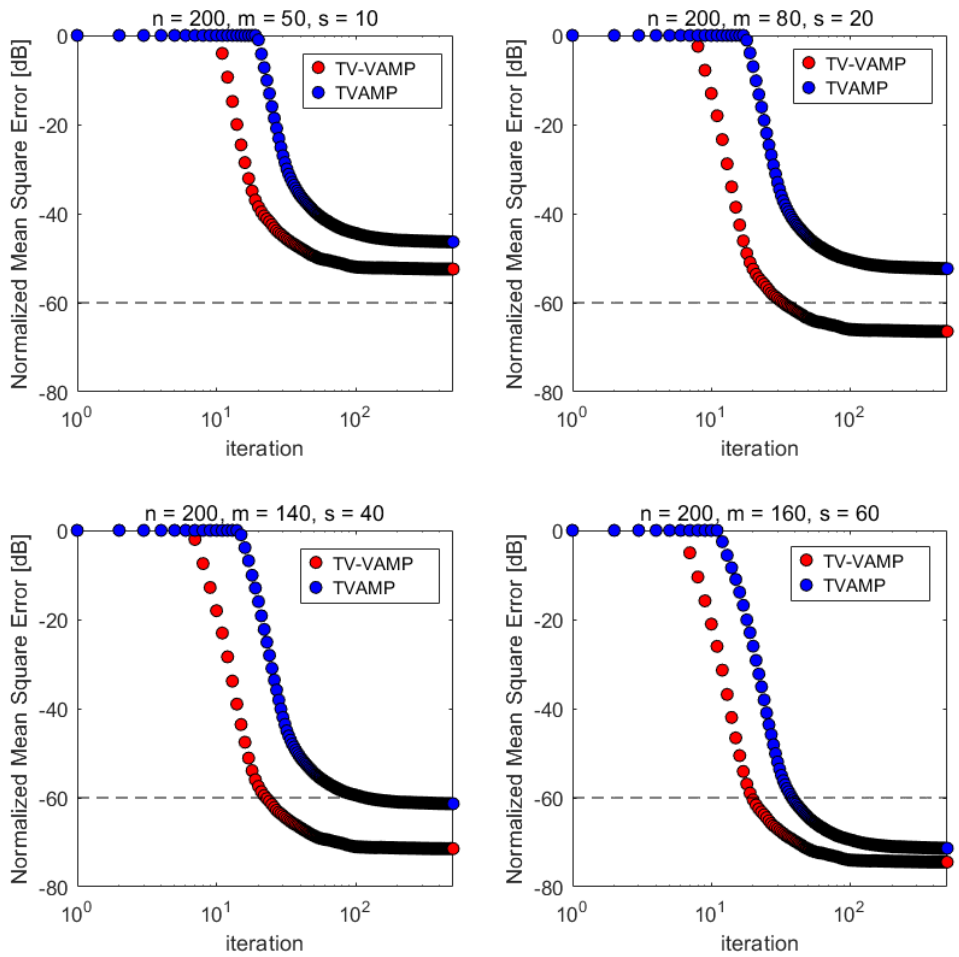
Figure 3. Normalized mean squared error (NMSE) convergence over iterations when A is a zero-mean Gaussian distribution measurements matrix. Each curve is the average of 50 Monte Carlo samples.